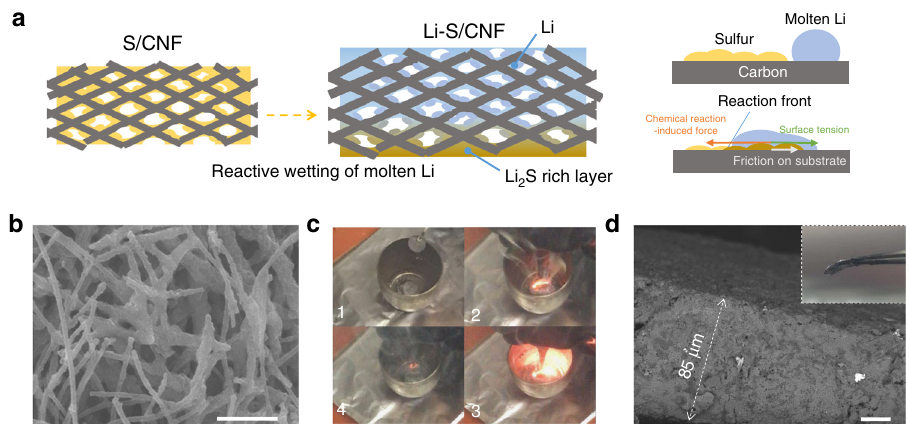
Fig. 1 The fabrication of Li – S/CNF. a Cartoons illustrating the fabrication process. b SEM of the surface of the pristine CNF; c snapshots taken during the fabrication, showing the sparkling reaction between molten lithium and the sulfur-impregnated CNF; d cross-sectional SEM of the Li/S – CNF. Scale bar for b , d is 5 and 20 µ